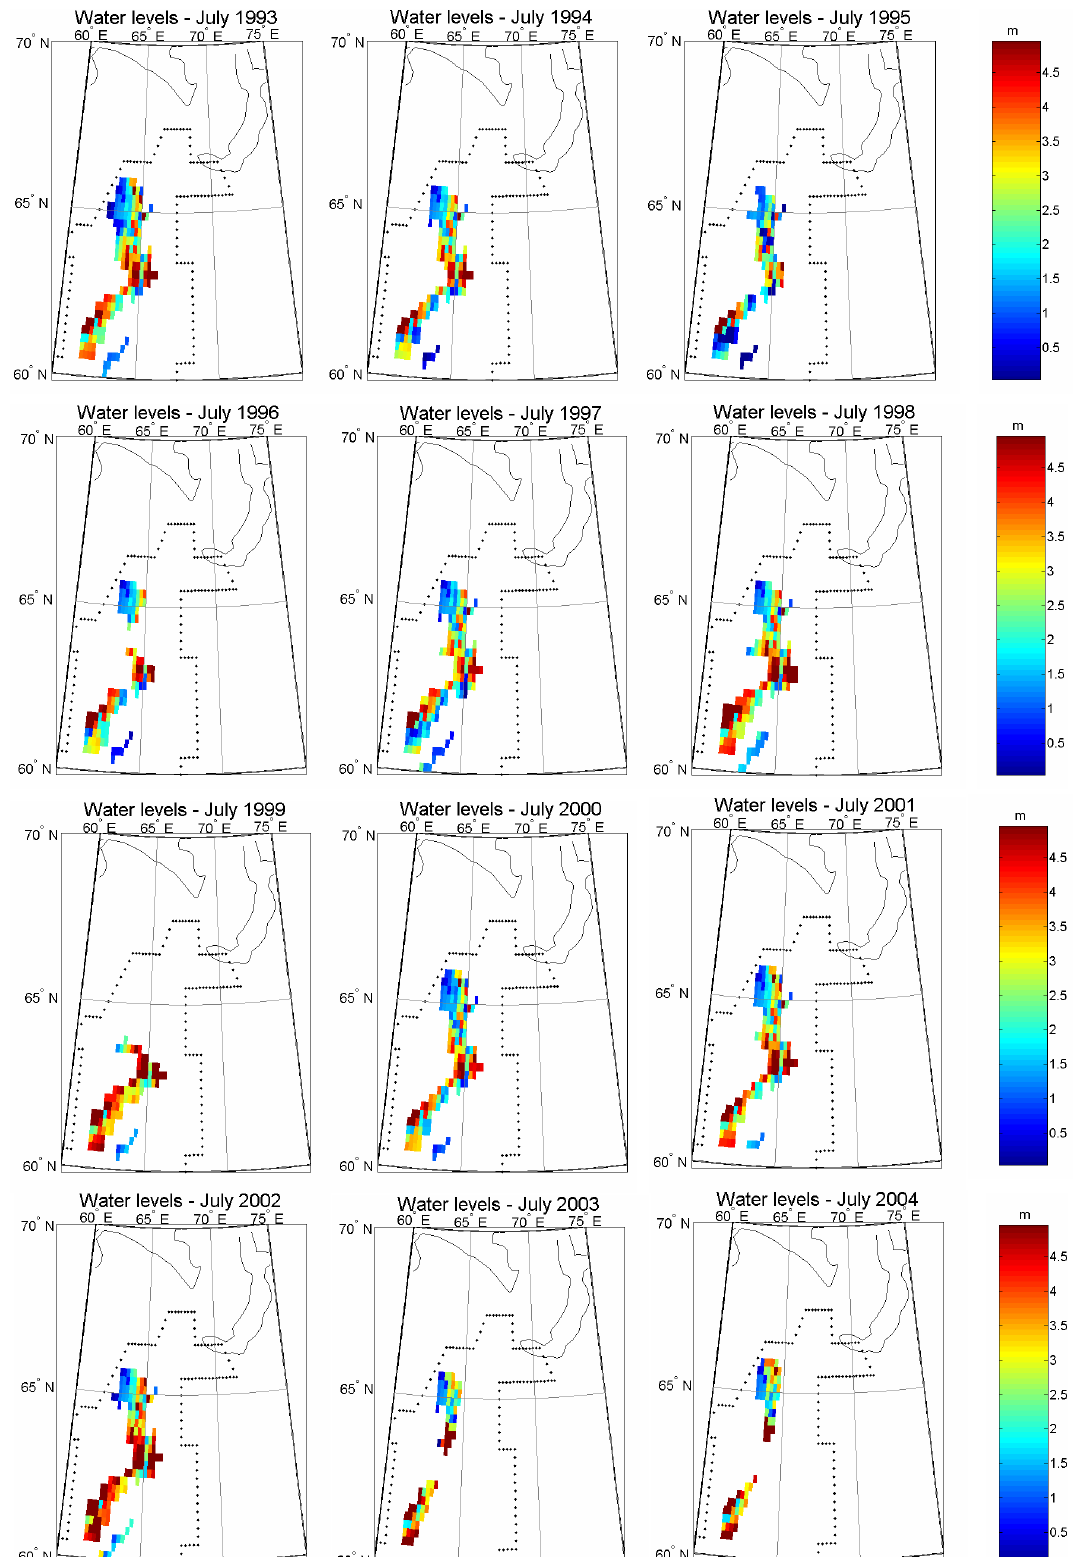
Water level maps during the peak flood